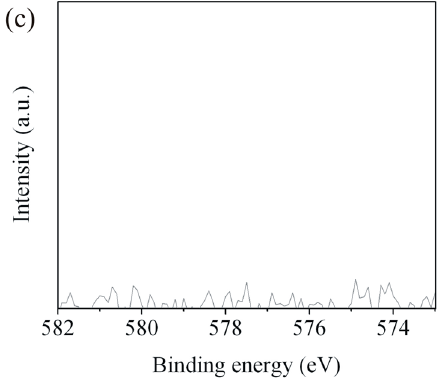
Figure 12. Cr 2p spectra of Zones: ( a ) A; ( b ) C; and ( c ) E.